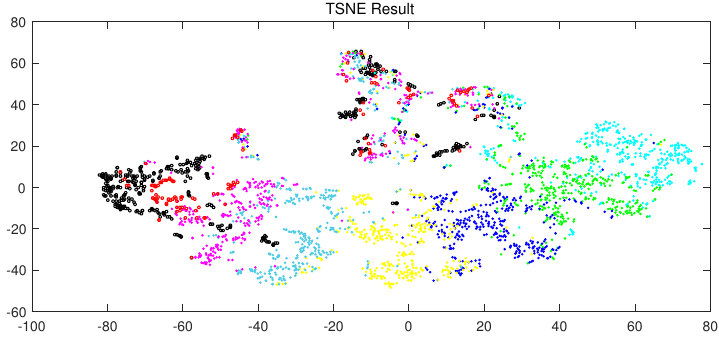
Figure 7. Visualization result of t-SNE dimension reduction.